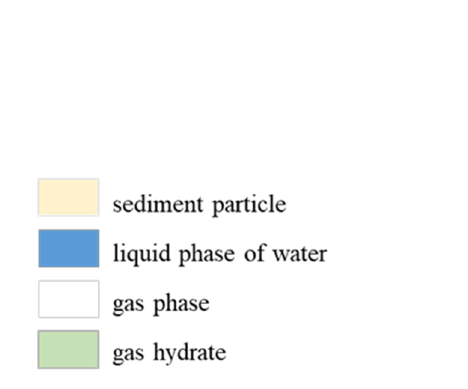
Table 4. Phase transitions of pore moisture of frozen hydrate-saturated sediments interacting with saline solutions depending on the accumulation of salts and the conditions for existence of pore methane hydrates (at stable (P ≥ P eq ) and metastable (P < P eq ) conditions). P is experimental pressure and P eq is equilibrium pressure. Detailed explanation in the text. e s Gas pressure g a P ≥ P eq P < P eq S t